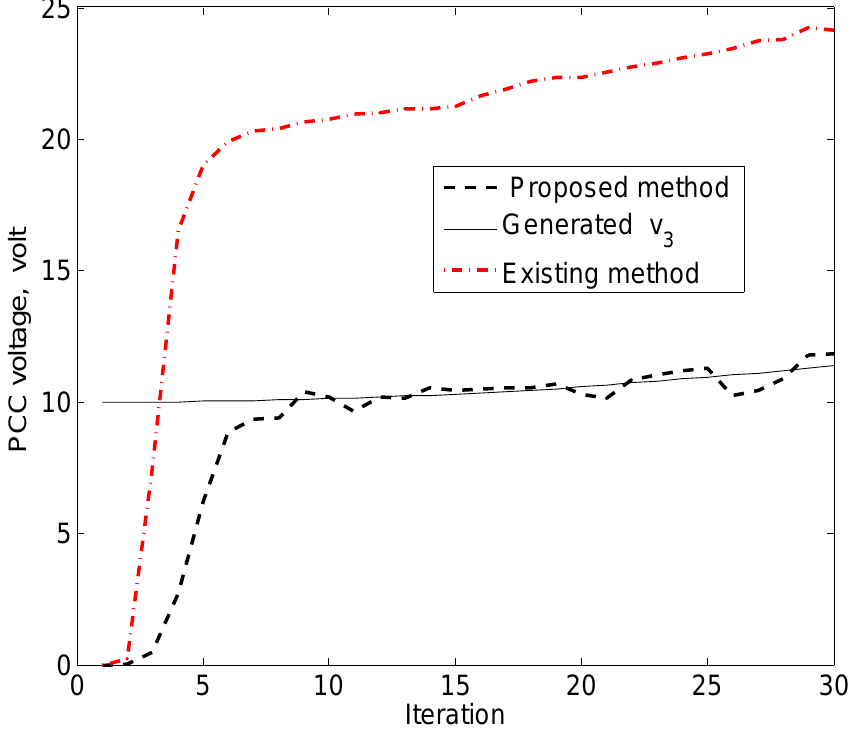
Figure 16. PCC voltage estimation for v